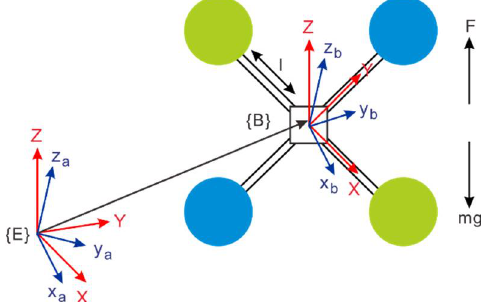
Figure 4. The UAV model.